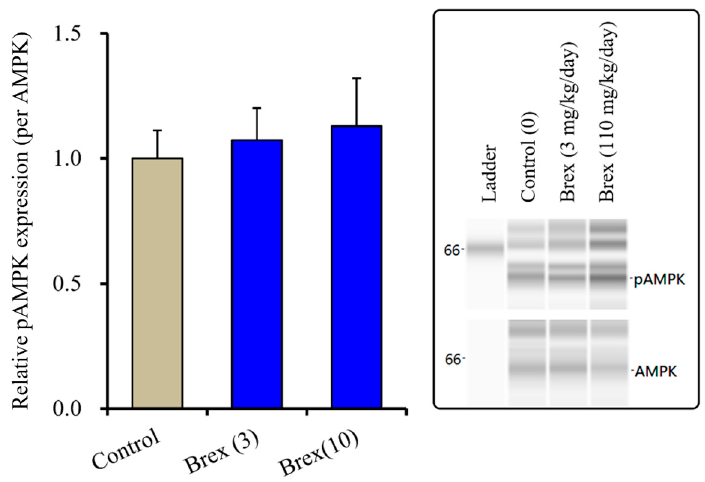
Figure 8. Effects of subchronically systemic administration (14 days) of effective doses of Brex (3 and 10 mg/kg/day) on protein expression of pAMPK in the rat hypothalamus. In left side histograms, ordinate: mean ± SD ( n = 6) of the relative protein level of pAMPK per GAPDH. Right side panels indicate their pseudo-gel images using capillary immunoblotting.